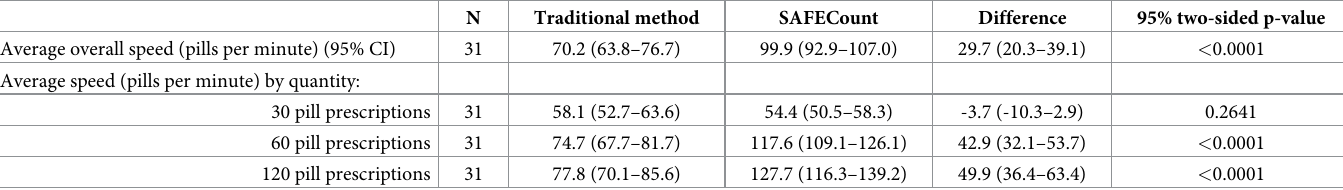
Table 5. Pill counting speed using traditional method versus SAFEcount.